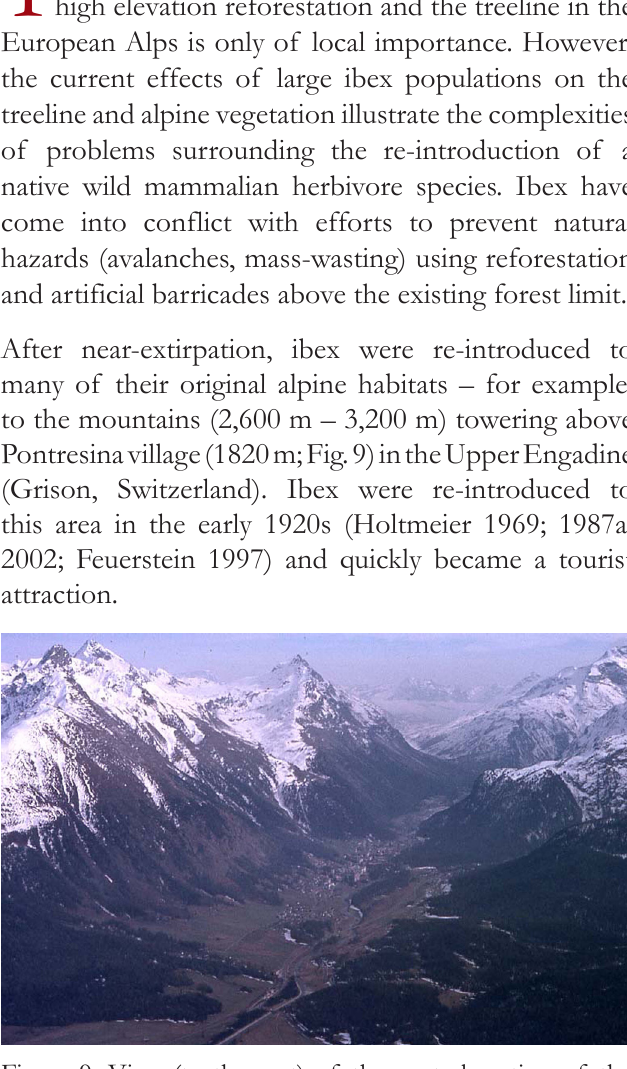
Figure 9: View (to the east) of the central section of the ibex reserve on the SW-facing slope (on the left) above Pontresina village. The terrain above the forest was grazed by sheep and cattle for centuries. Photo taken by the author, beginning of October 1973.